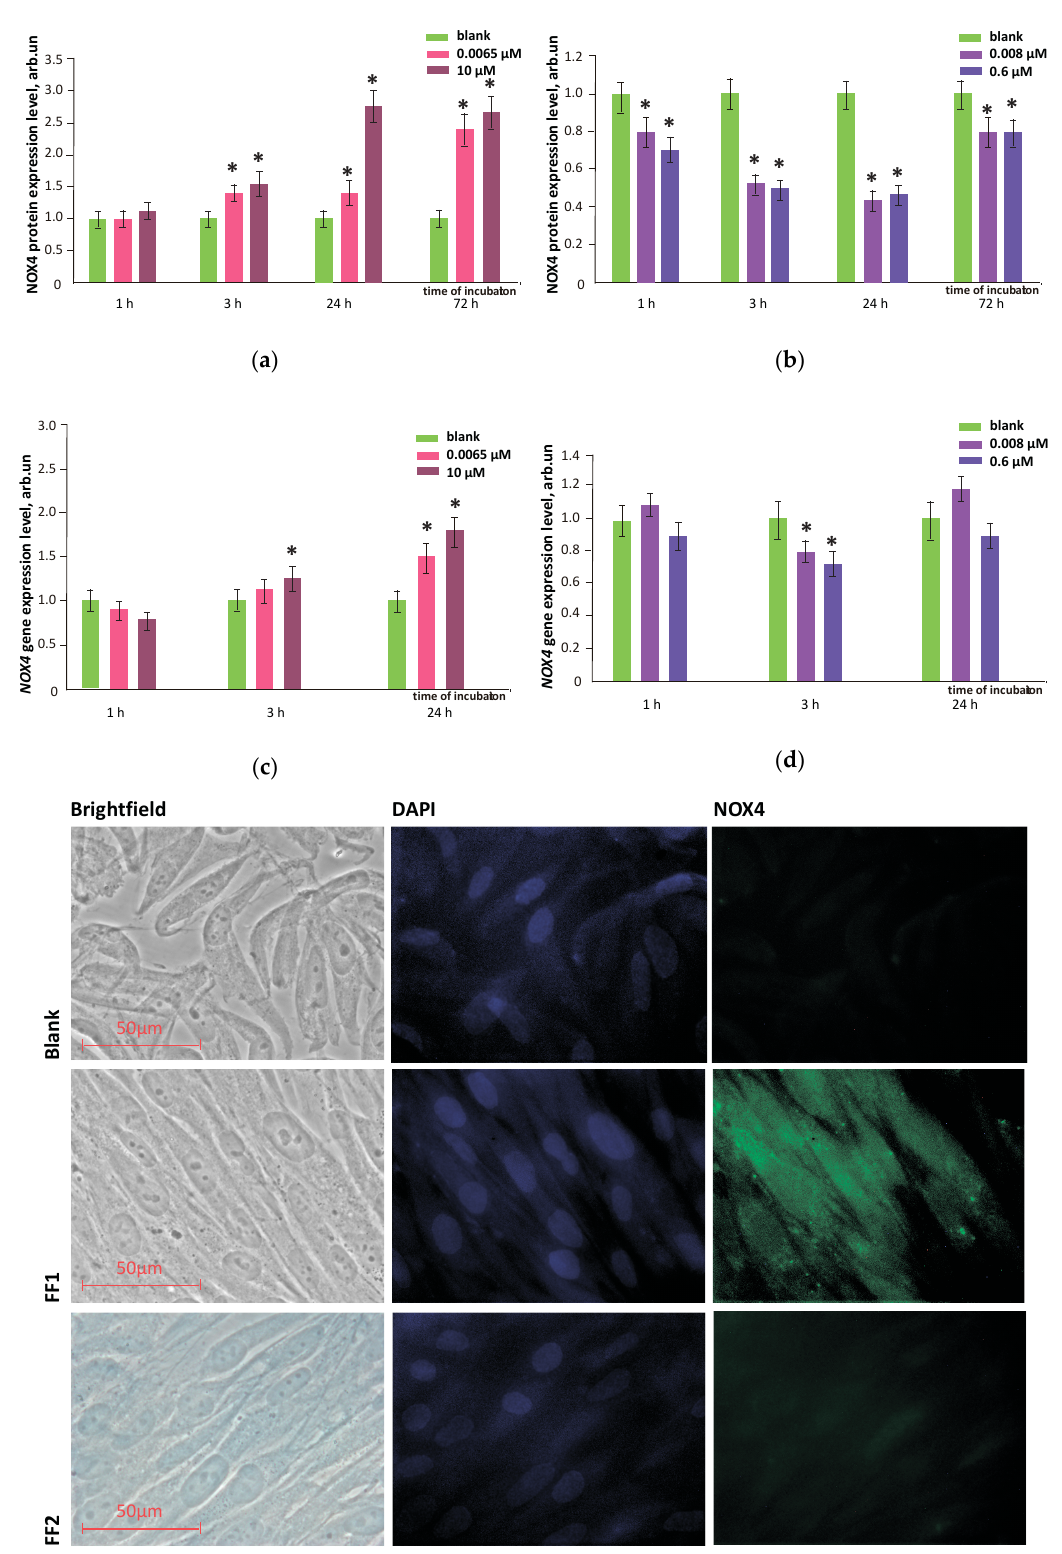
Figure 10. NOX4 protein level in HFLF treated with ( a ) FF1 and ( b ) FF2 in the concentrations shown in